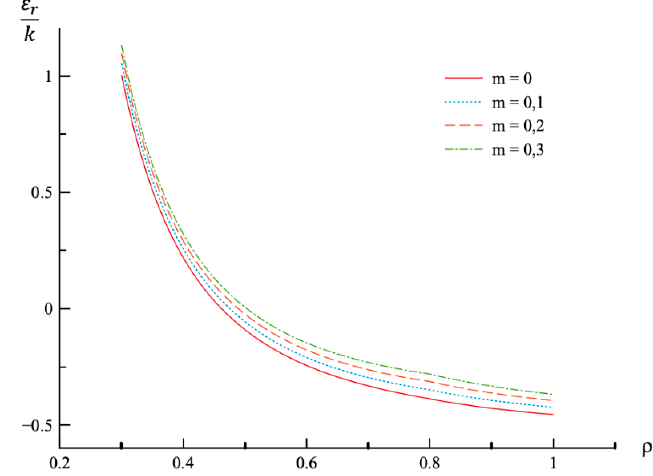
σ , with the dimensionless radius,